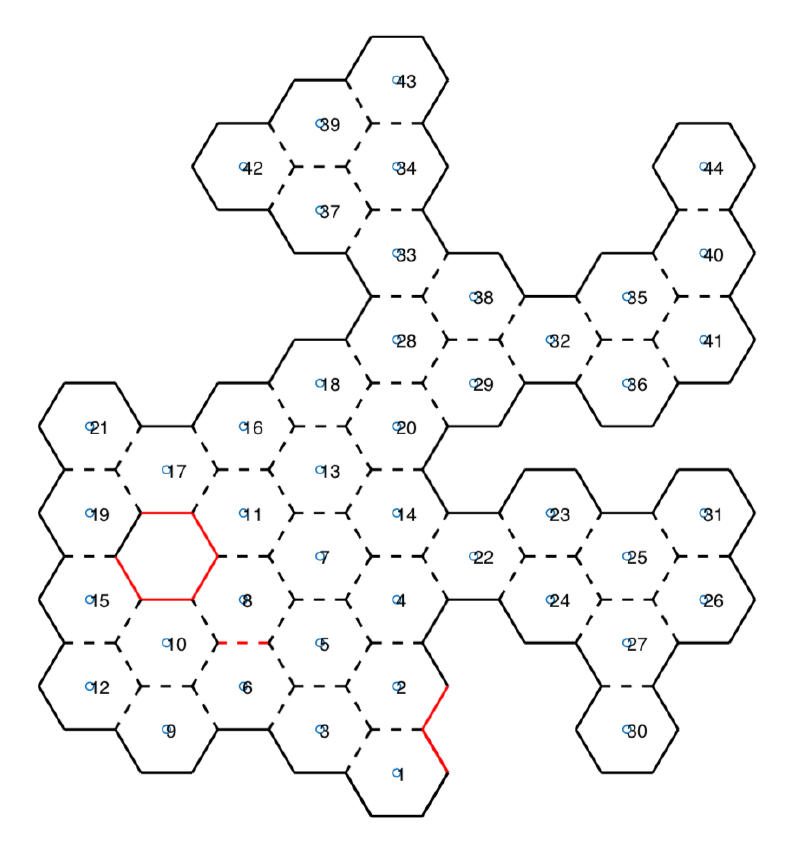
Figure 6. Honeycomb